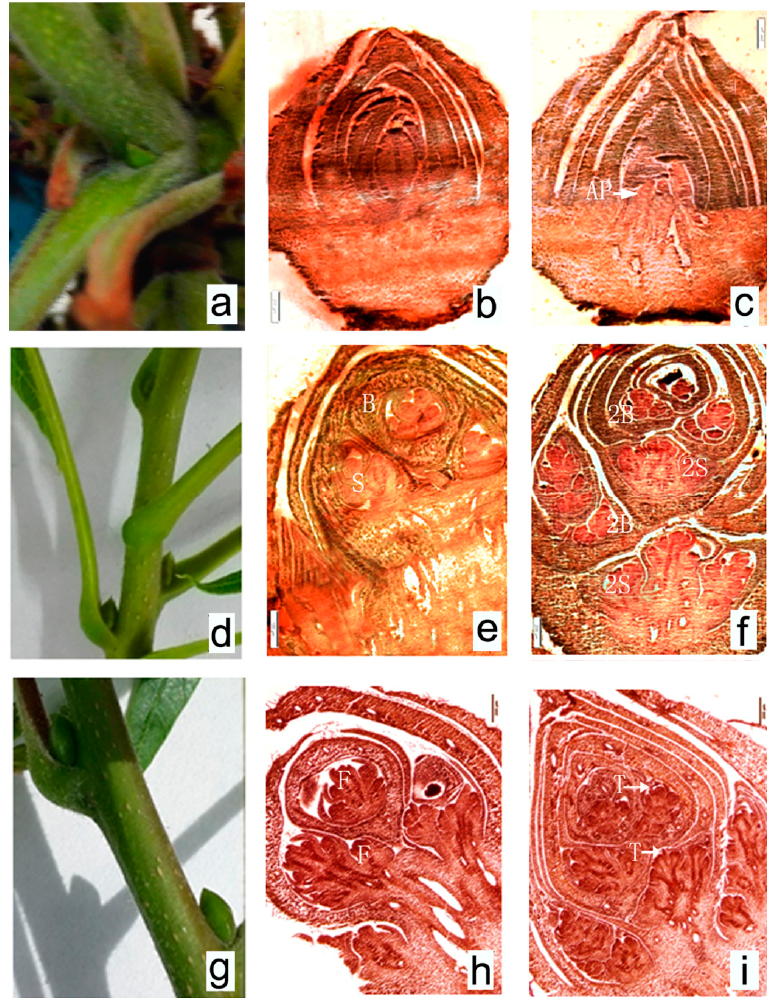
Figure 4. The external and internal morphological changes of flower buds during the undifferentiated and initial phases in monoecious Pistacia chinensis . Undifferentiated phase ( a , b ) and initial differentiation phase ( c – i ). The white marks in these pictures are: AP, apical point; B, bract; S, shoulder; 2B, secondary bract; 2S, secondary shoulder; F, floret; T, tepal (bar = 200 μ m).